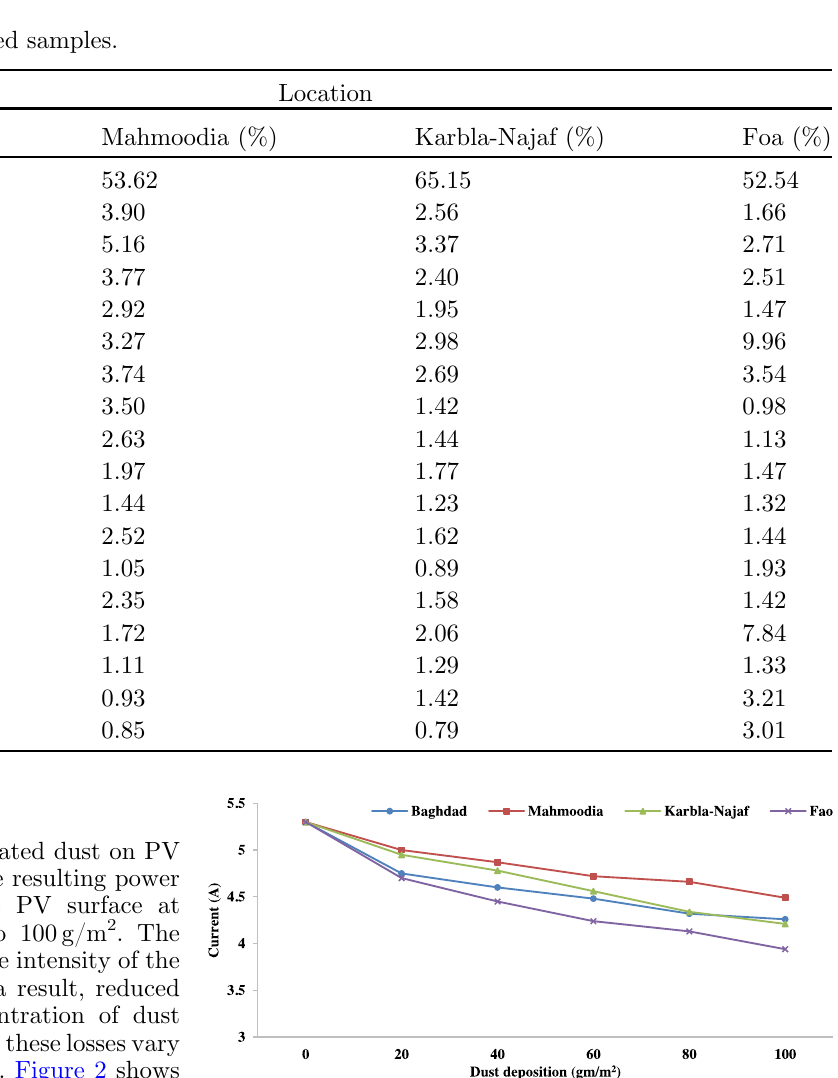
Fig. 2. Current losses due to dust accumulation on PV.